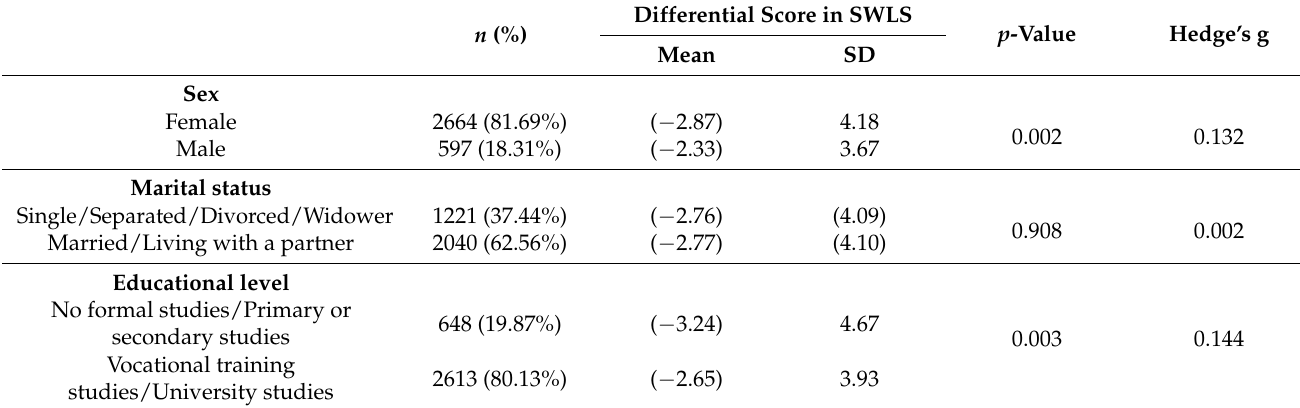
Table 1. Comparison of differential score in the Satisfaction with Life Scale (SWLS) according to categorical